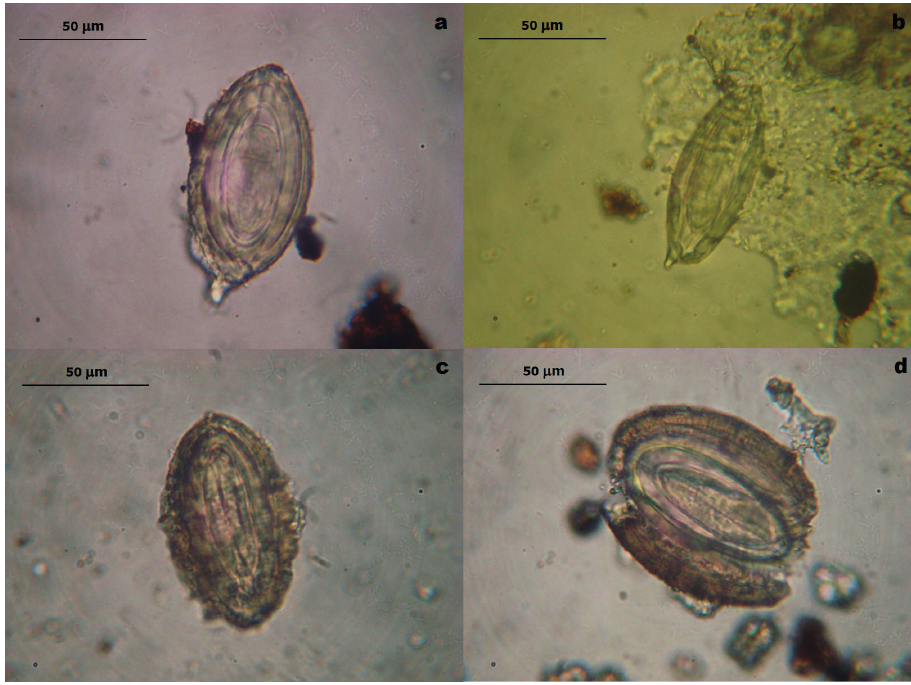
Figure 6 - Photomicrographs of Acanthocephala eggs recovered in coprolite preliminary assigned to Crocodyliformes from the Adamantina Formation, Bauru Group, Upper Cretaceous, Santo Anastácio